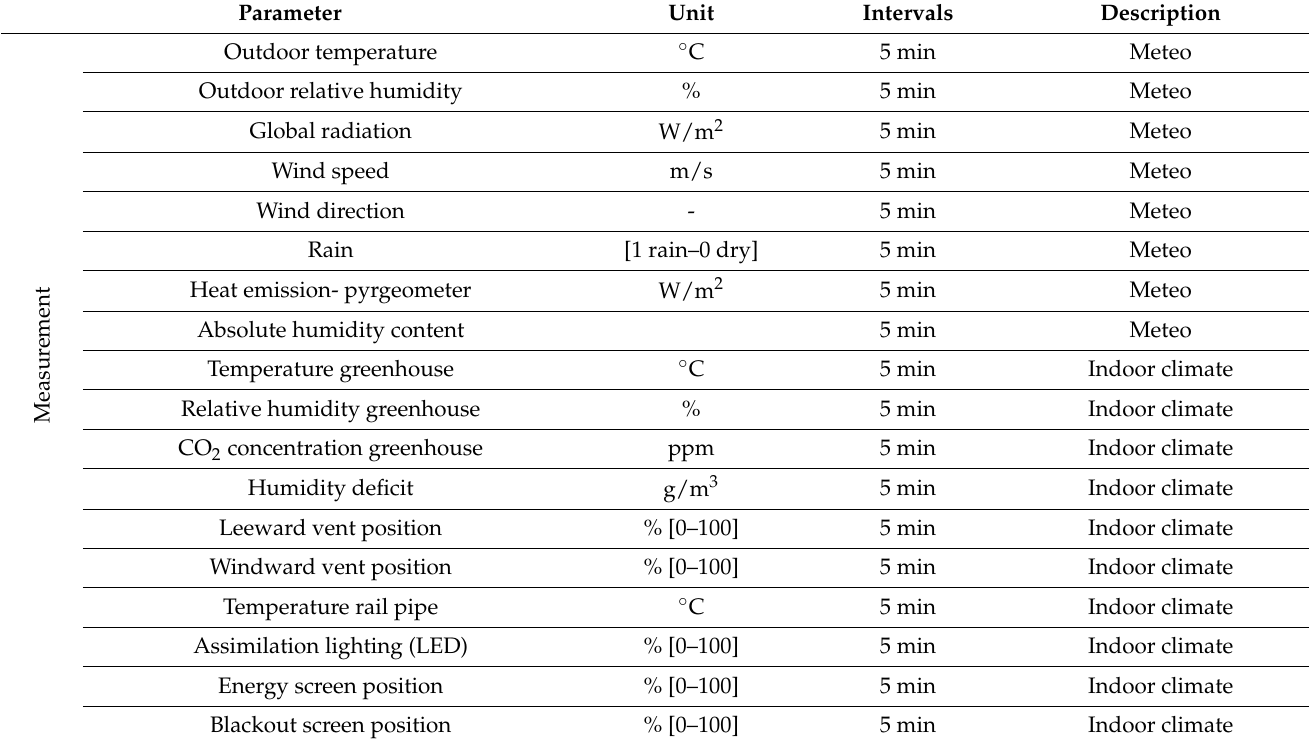
Table A1. Data collected throughout the cultivation cycles for all greenhouse compartments on outdoor and indoor greenhouse climate, weather forecast, requested and realized operational controls, weekly destructive plant measurements on which images were annotated, and final harvest plant data. Data are open access [49,56]. Unit